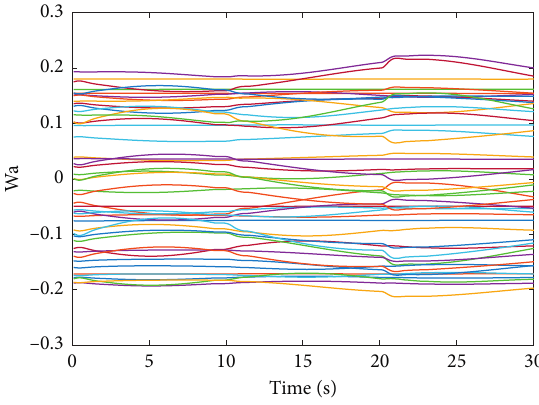
Figure 18: Wa1 of action network.